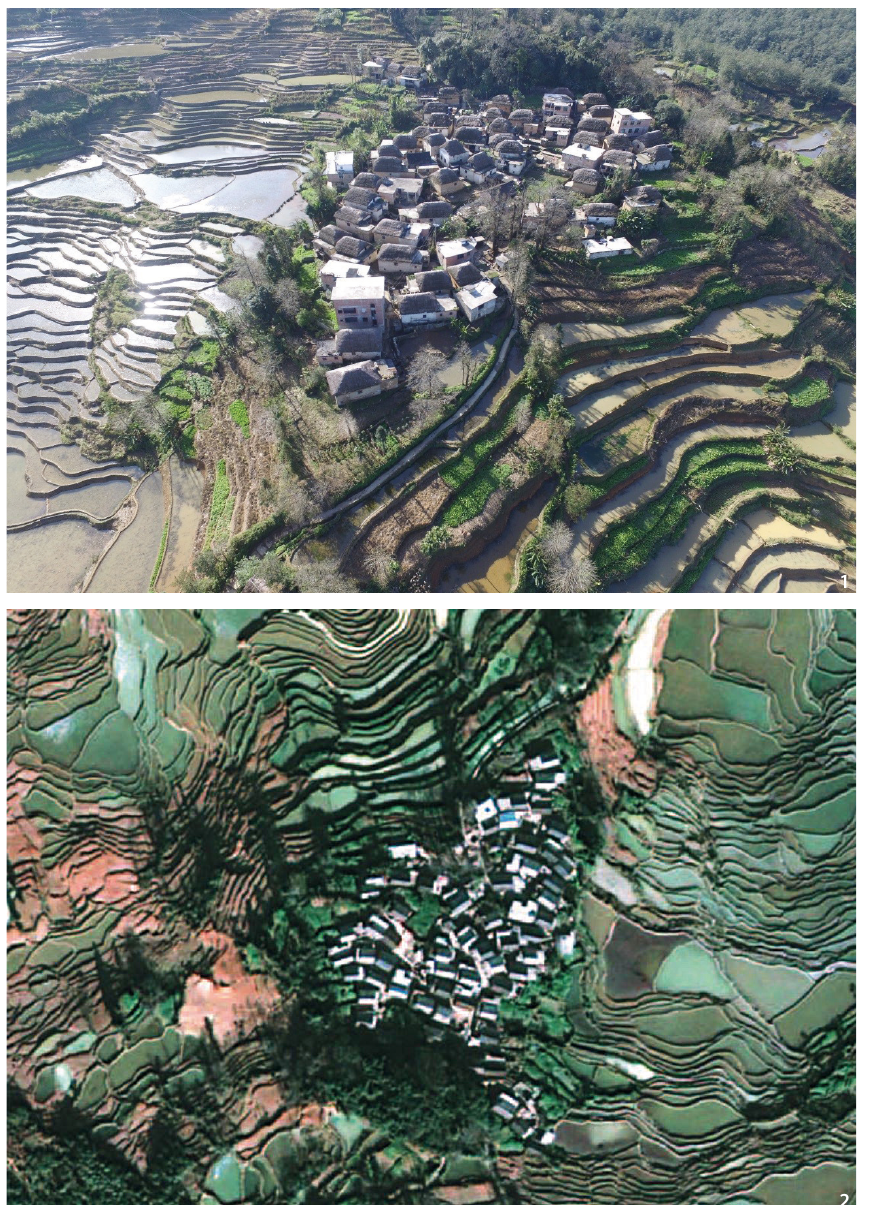
Figure 1 Overall Perspective of Hani Rice Terrace at Azheke Village (Source: Guangqiang Zheng). Figure 2 Landscape of the terraced fields (Source: World Heritage Convention Cultural Heritage Nominated by People’s Republic of China, Cultural Landscape of Honghe Hani Rice